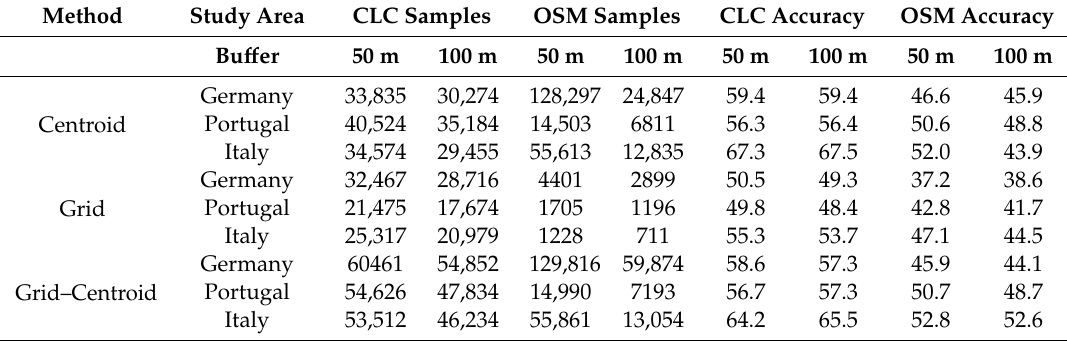
Table 1. Number of samples and overall accuracy (%) for the two bu ff ers and three sample